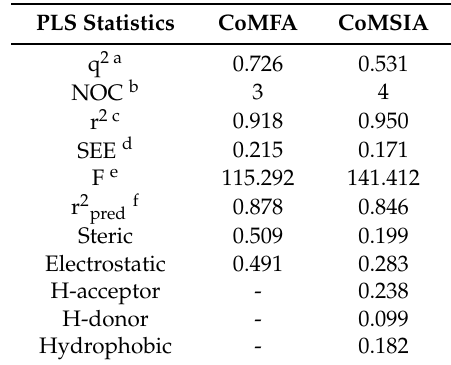
Table 2. The PLS statistical results of CoMFA and CoMSIA model.